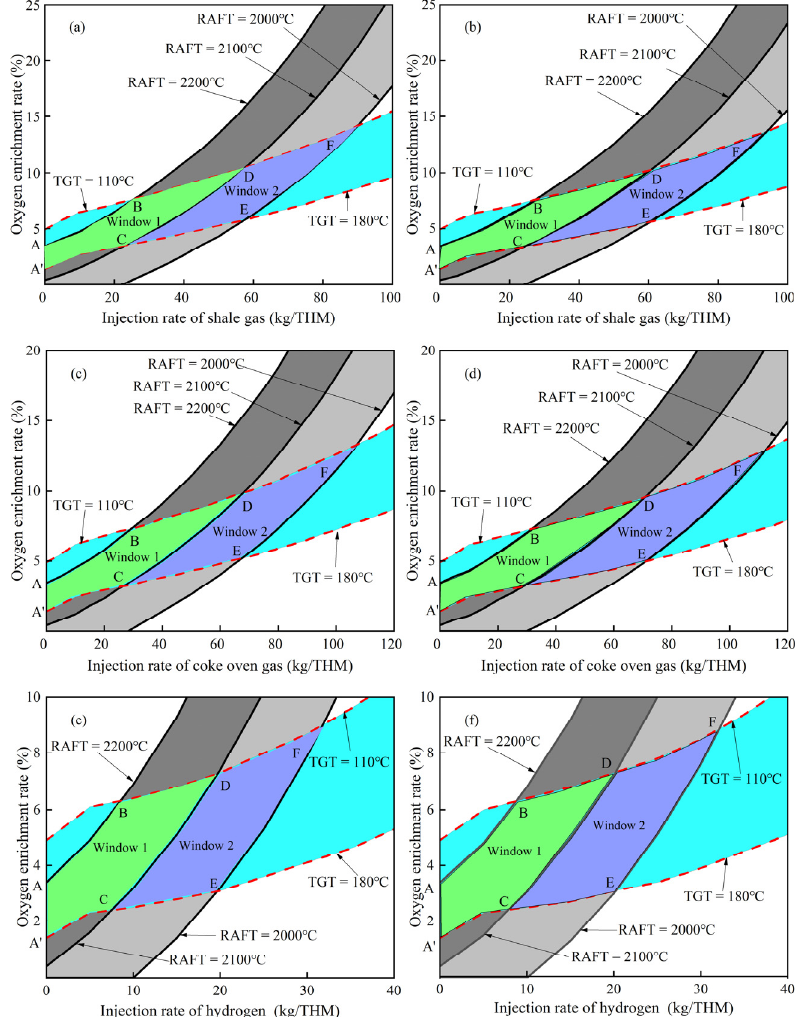
Figure 6. Influence of hydrogen − rich gas temperature on operation window: ( a , c , e )—25 °C; ( b , d , f )— 600 °C. The uppercase letters (A − F) in the figure represent the vertices of the operation window.